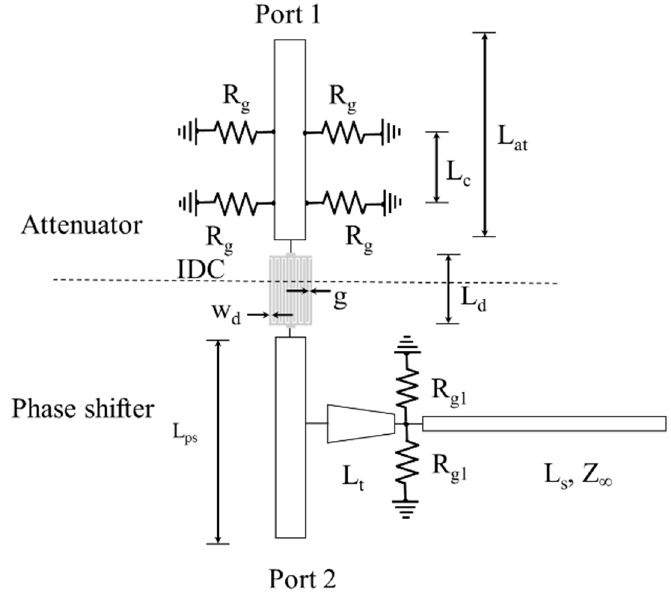
Figure 2. Block diagram of the amplitude-phase variation transmission line with the attenuator coupled to the phase shifter via the IDC. Using different bias voltages, the characteristics of both components are controlled.